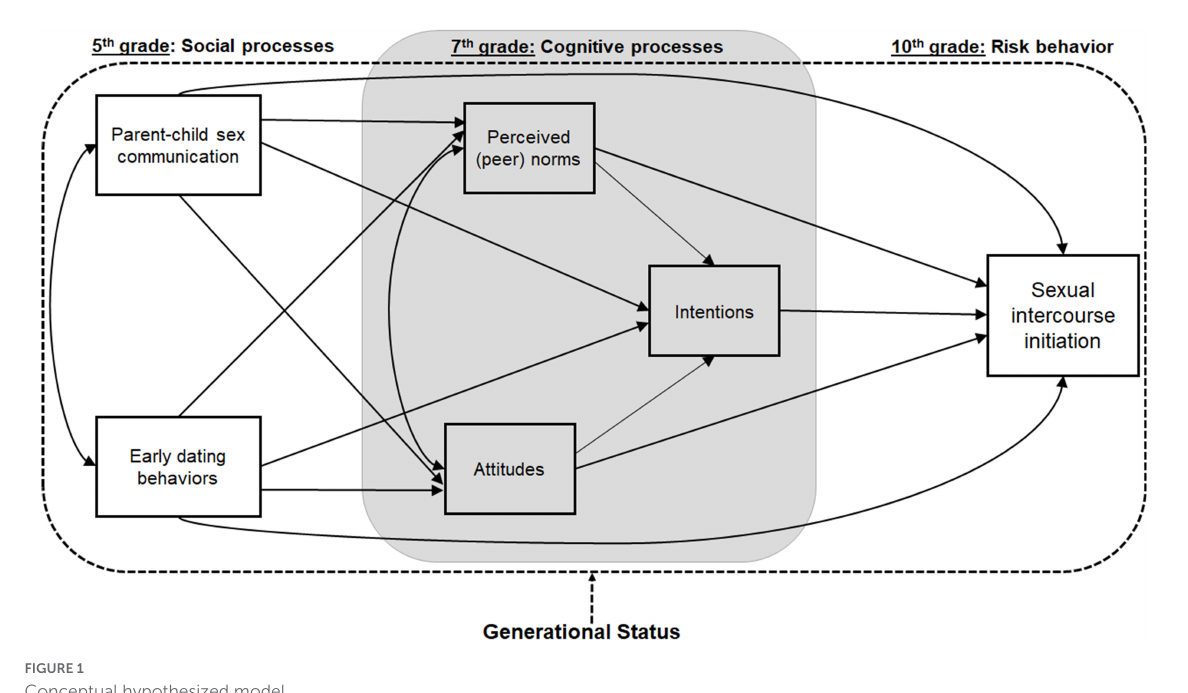
FIGURE1 Conceptual hypothesized